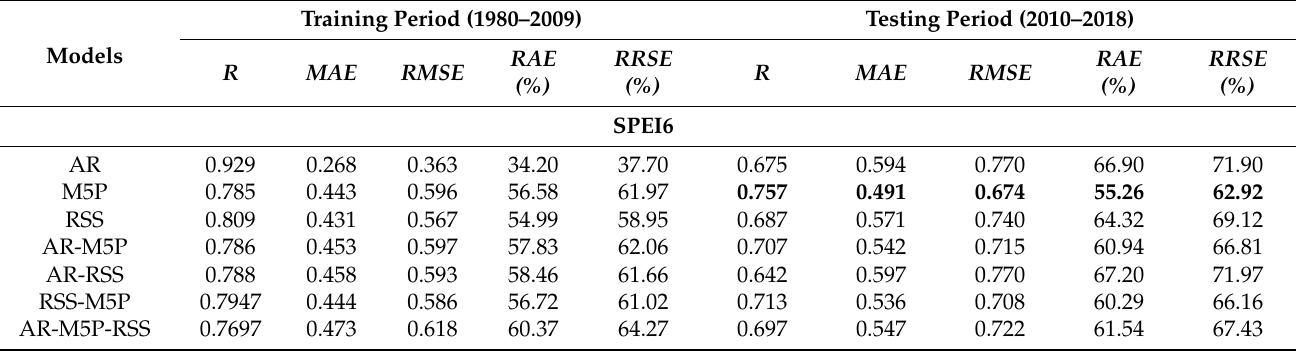
Table 5. Computed statistical index values for the eight machine learning models (individual and hybrid) during training and testing